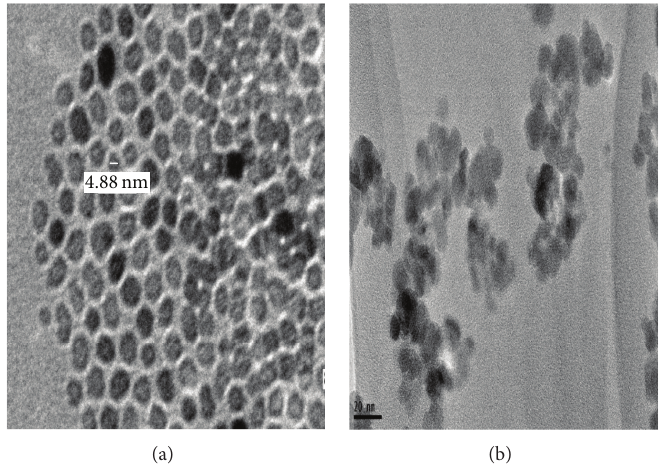
Figure 2: TEM of (a) magnetite and (b) Fe 3 O 4 /p(AMPS) nanogel.